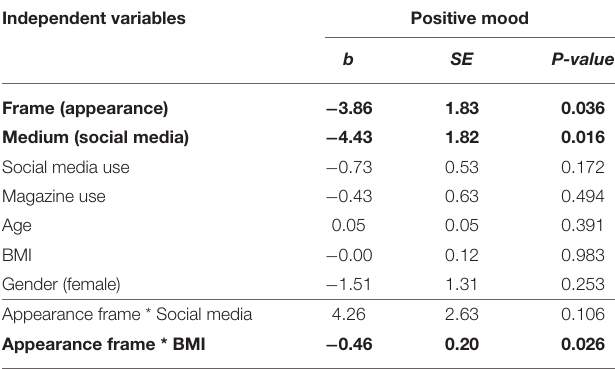
TABLE 3 | Moderated analysis explaining body satisfaction.